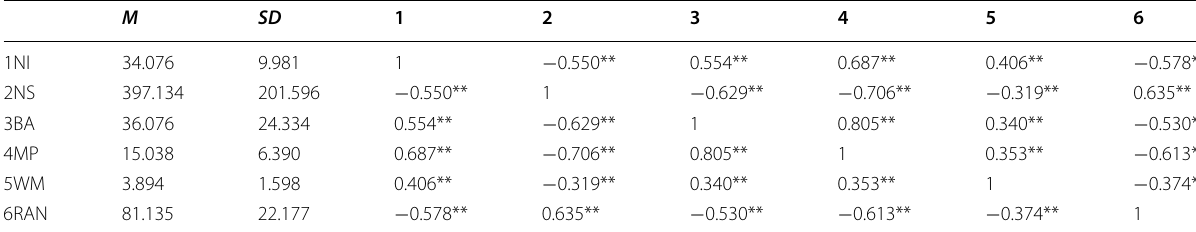
Table 1 Correlation analysis of variables